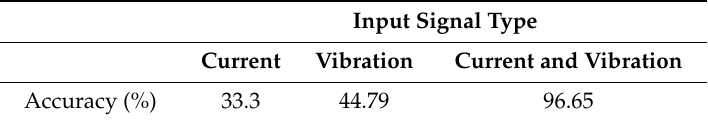
Table 3. Validation accuracy comparison for current ( I ) and vibration ( g ) as input individually and combined.